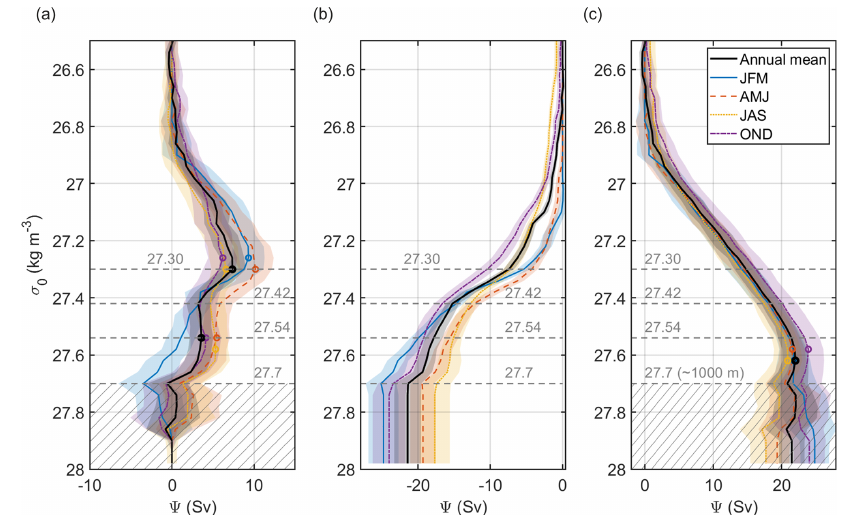
Figure 9. (a) Overturning stream function ψ for the full SPG boundary in density space between surface and seabed using corrected veloc- ities for sub-1000m currents. Density of maximum overturning and that of secondary peak (where applicable) are highlighted by circles. Densities of mean inflection points marked by horizontal dashed grey lines; these are overlaid on Fig. 3c and d. The hatched area denotes the approximate density space impacted by the sub-1000m correction velocities (see Sect. S5 for details). Panel (b) is the same as (a) but for boundary contour (0–9500km) only, while (c) is the same but for the 47 ◦ N transect (9500–12700km) only.